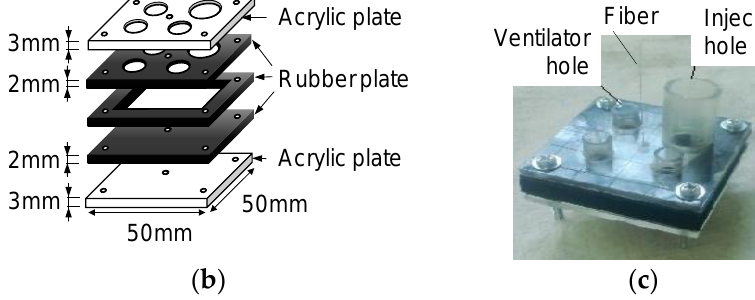
Figure 9. Pullout specimen: ( a ) dimensions of pullout specimen; ( b ) constitution of mold; ( c ) setup of mold.